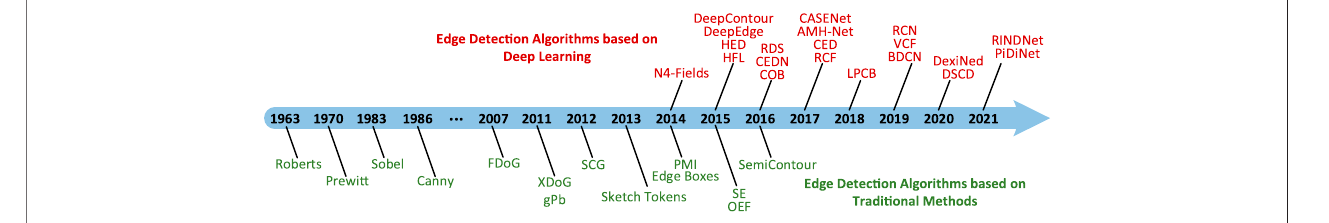
FIGURE 1 | Development of edge detection algorithms based on traditional and deep learning